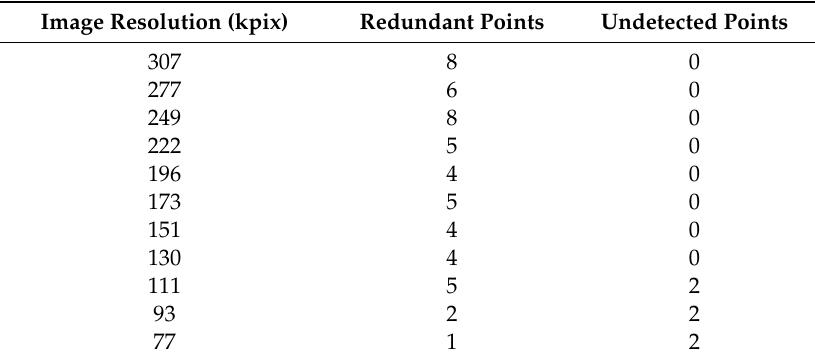
Table 1. Influence of image resolution on the number of redundant